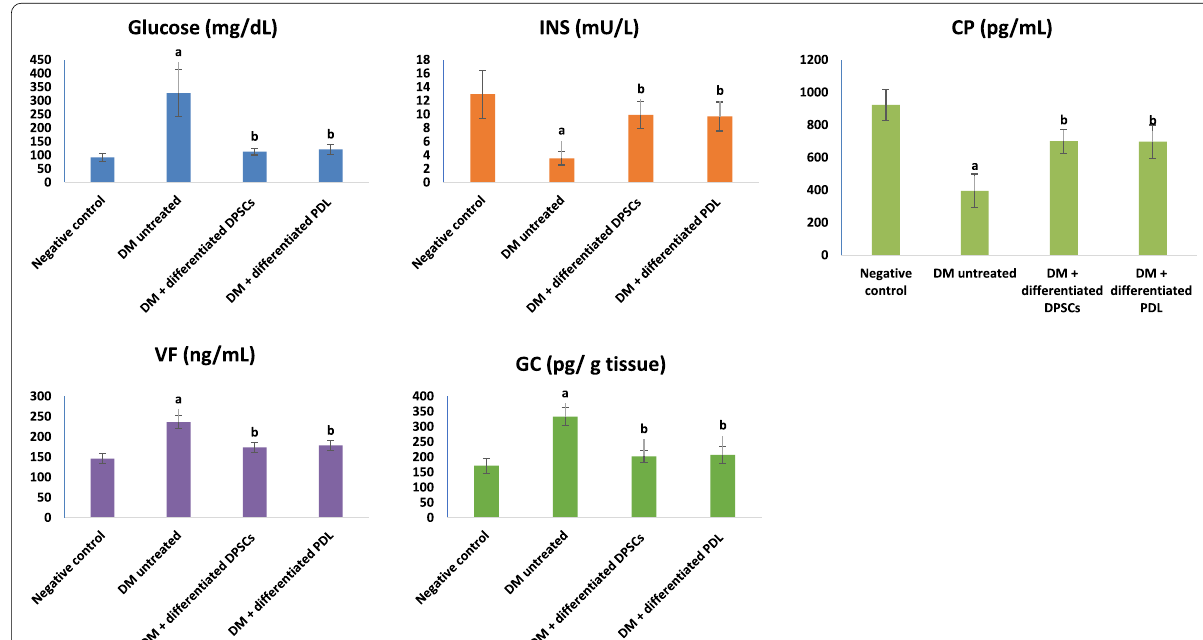
Fig. 8 Effect of IPC implantation on (i) blood glucose, serum (ii) INS, (iii) CP, and (iv) VF as well as (v) pancreatic GC levels. Data are expressed as means SD of 8 rats/group. Significant change at P < 0.05 in comparison with the negative control group denoted by (a). Significant change at P < ± 0.05 in comparison with the untreated DM group denoted by